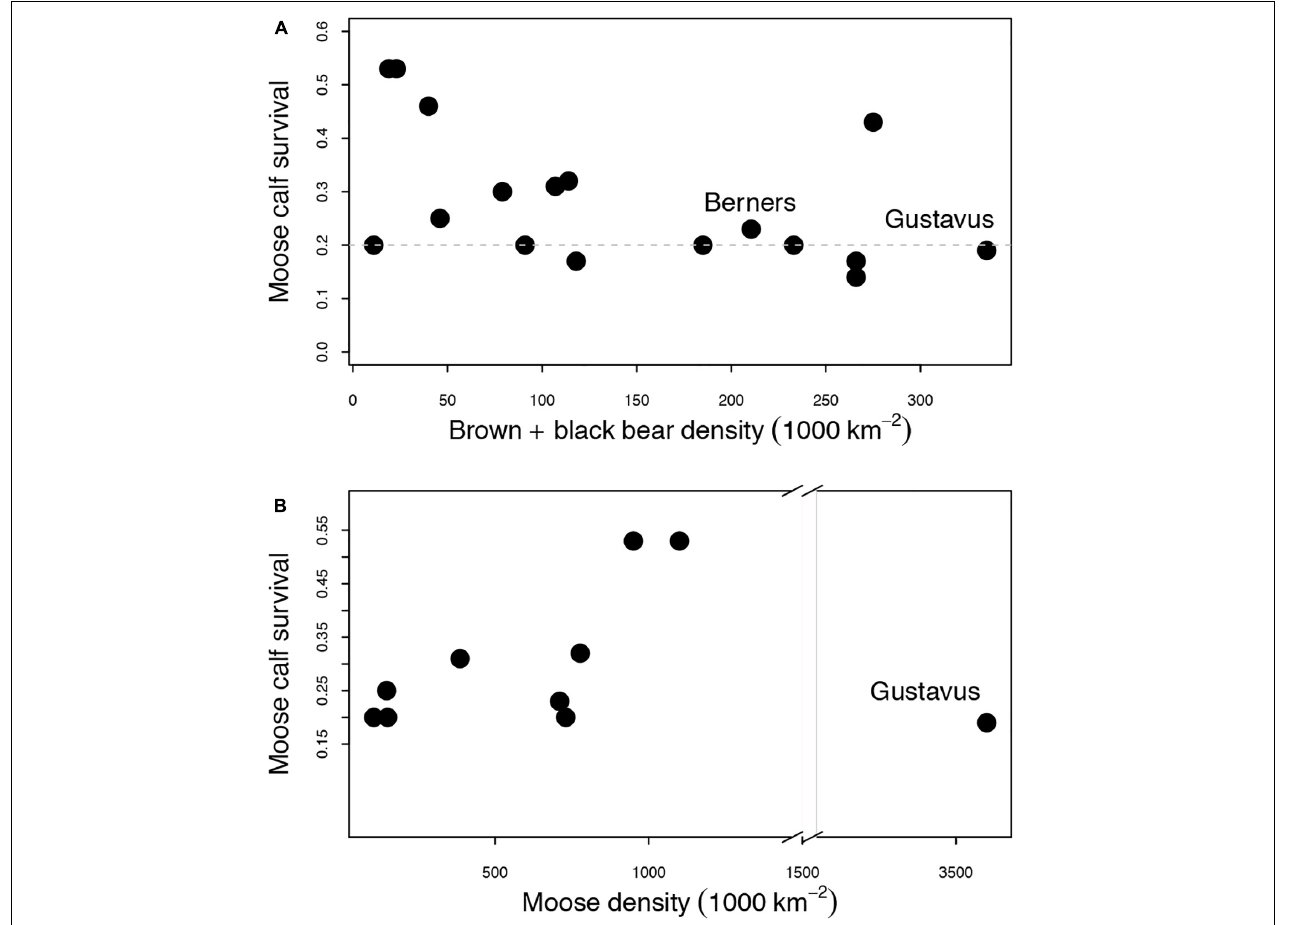
FIGURE 6 | Empirical relationship between (A) total bear density (black + brown bear) and moose calf survival across 12 populations in Alaska, and (B) between moose density and moose calf survival (see Supplementary Table 1 ). Average moose calf survival stabilized near 20% over a broad range of bear densities but increases at very low bear density. Moose calf survival increased with moose density, which is counter to expectations if bear prey-switching as moose calves become rare is responsible for the invariance of calf survival to bear density. The exception is the Gustavus moose population, which is highlighted because the research occurred in the distinct context of a moose population irruption after moose first colonized the study area. Berners is highlighted because bear density is a gross underestimate with only the minimum number of black bears captured as bycatch during a brown bear survey included as part of the black bear density estimate. The true black bear density may be an order of magnitude higher (i.e., if 10% of black bears were caught as bycatch), and we postulate that Berners, which is a salmon-fed system with the highest brown bear density, has substantially higher bear density than all other study areas.